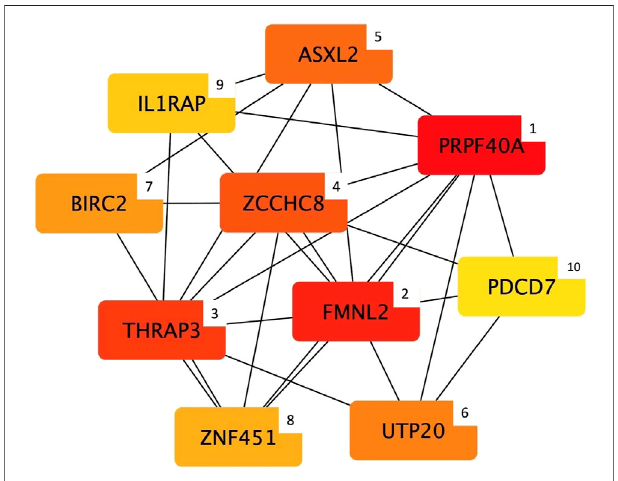
FIGURE 4 | Top 10 hub genes entering the width module (i.e., group of co-expressed genes and whose mRNA level covaried with the breast width in normal and White Striping/Wooden Breast affected Pectoralis major muscles in 52-day-old broilers. Connections show how functional categories interact with each other). The cytoHubba output shows hub nodes with the most signi fi cant MCC values (i.e., genes characterized by the highest number of connections in the considered network). Besides, the plugin classi fi es the 10hubgenesbyrankingthem considering theirMCCvalueand usingacolor- ranging scale: from the dark red (most important hub gene) to the light-yellow (less important hub gene), also indicated by a numerical scale from 1 (most important) to 10 (less important).